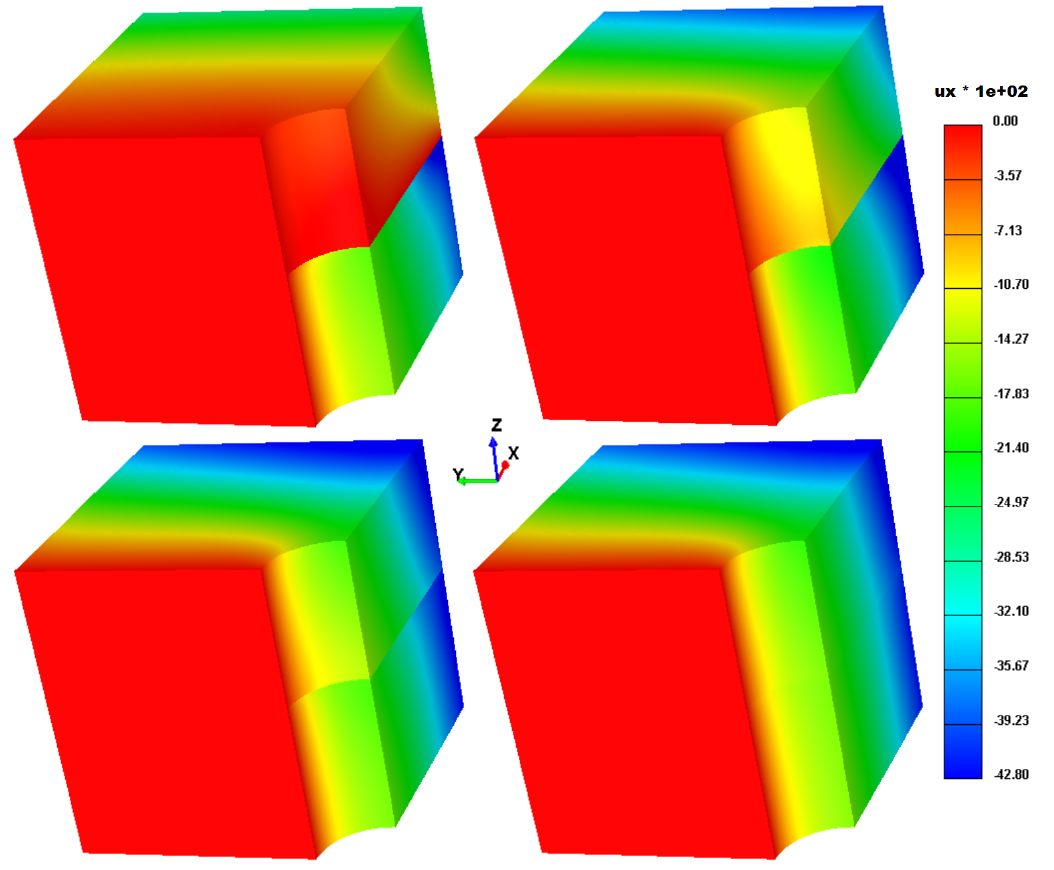
Figure 19. DN snapshots for u x